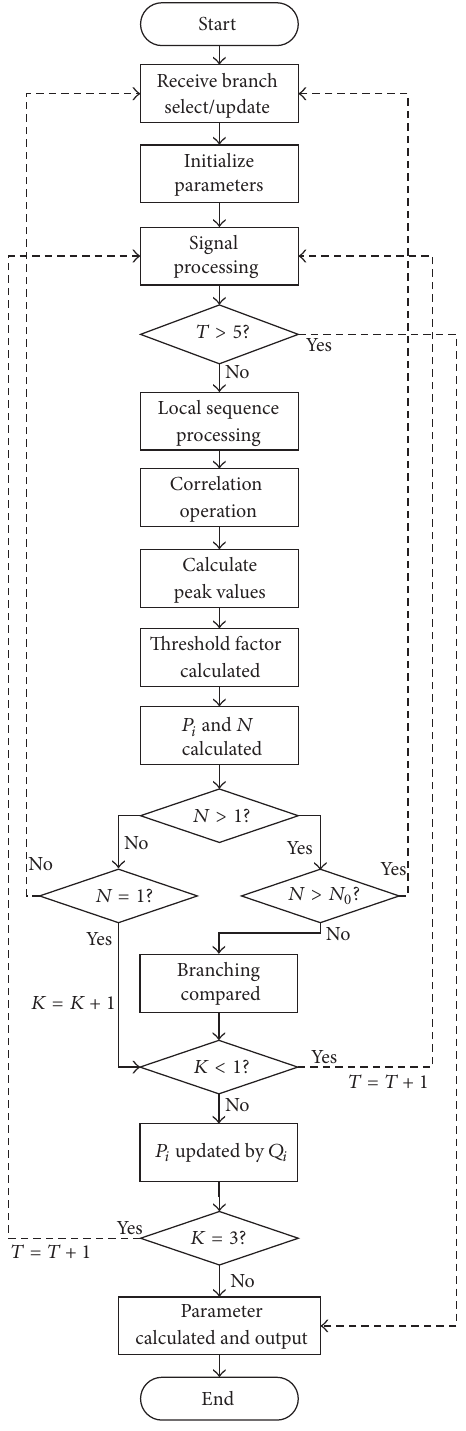
Figure 6: Overall flow of